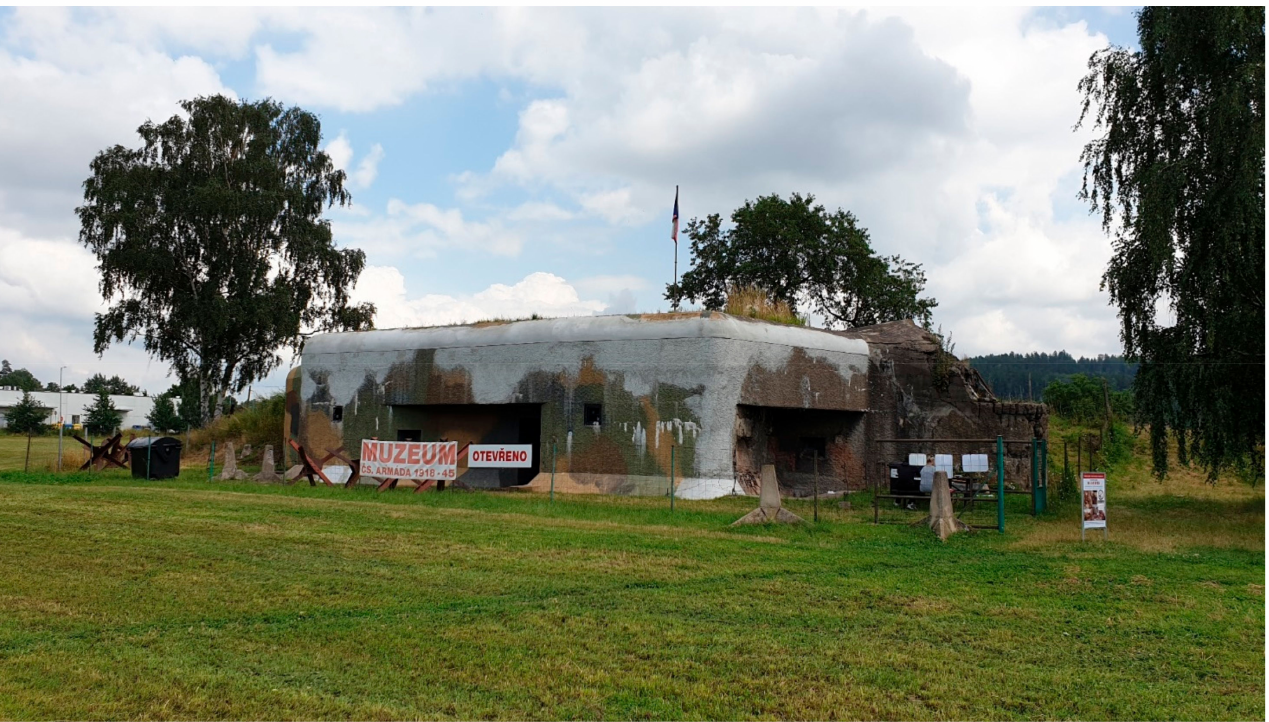
Figure 1. Damaged heavy bunker N-S 84 “Voda” in the town of N á